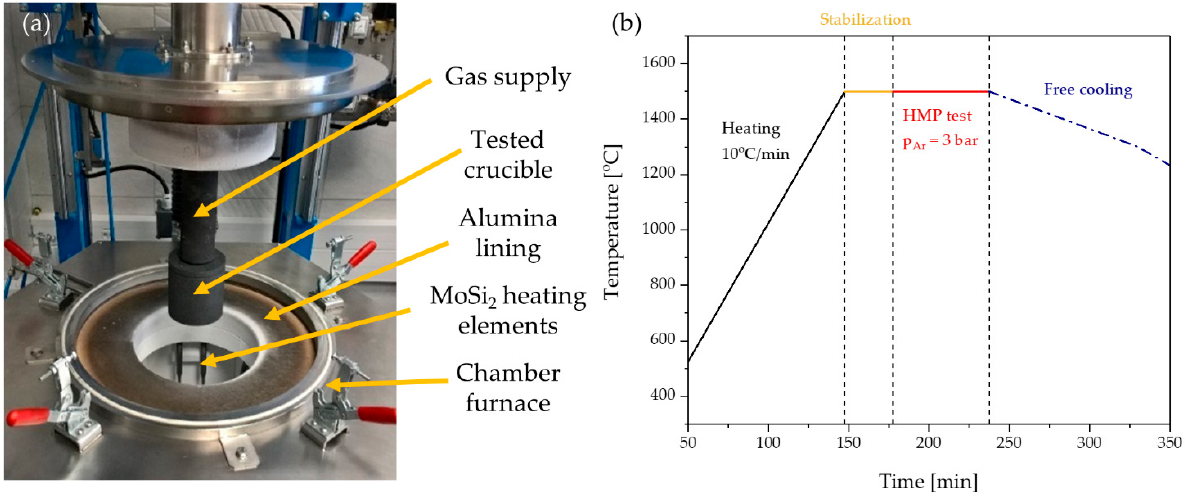
Figure 2. ( a ) Photo of HMP apparatus. ( b ) Heating curve during the HMP test.